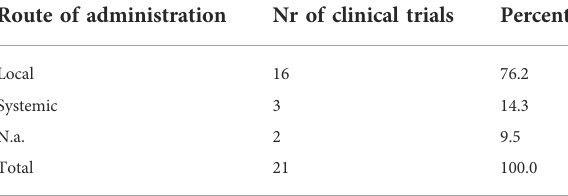
TABLE 5 Distribution of different routes of administration of TF.